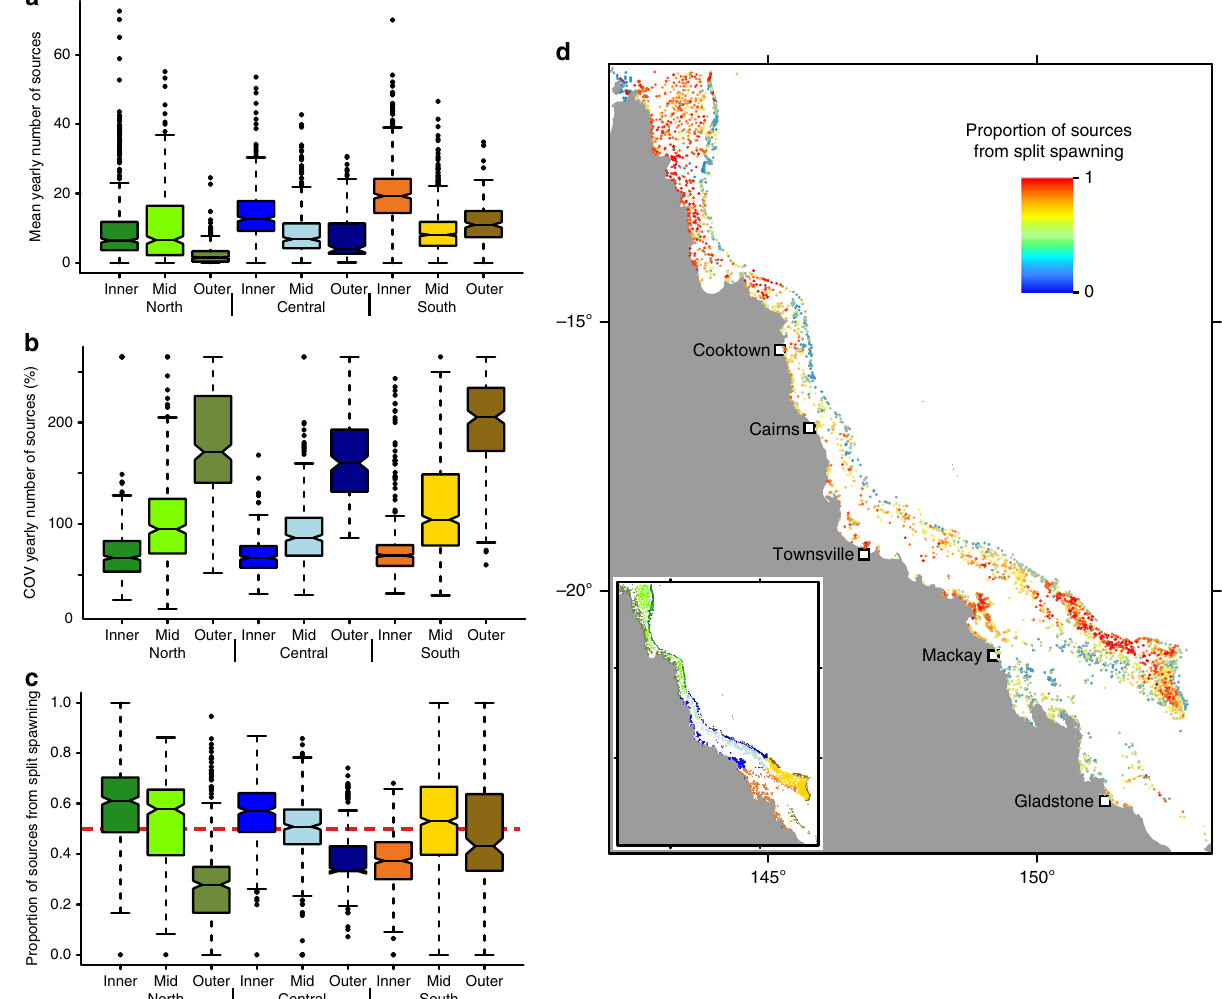
Fig. 3 Patterns of the diversity of external larval sources and the effects of split spawning. Relative number of sources of coral larvae for reefs in each GBR section with split spawning summarized as ( a ) mean number of sources per year and ( b ) temporal variation in the number of sources expressed as the coef fi cient of variation of the annual number of sources. ( c ) Mean proportion of annual sources contributed by the second spawning in split spawning scenarios. For reference, a value of 0.5 (red dashed line) implies that an equal number — but a distinct set — of sources are provided by each consecutive spawning month. ( d ) Map showing locations of reefs and the mean proportion of sources reef contributed by the second spawning in the split spawning scenarios. The colours of the boxes in ( a ), ( b ) and ( c ) correspond to the colour scheme of the GBR sectors shown in the inset in ( d ). In boxplots, the centre line represents the median, the upper and lower limits of the box represent the third and fi rst quartile respectively, the notches in the boxes represent the con fi dence interval around the median (equal to ±1.58 times interquartile range divided by square root of the sample size), the whiskers extend up to 1.5 times the interquartile range from the bounds of the box, and the points represent outliers beyond the limits of the whiskers. In ( d ) blue hues show reefs that had most of their larval sources in the fi rst spawning of the year, red hues show reefs that had most of their larval sources in the second spawning of the year, and yellow hues show reefs that had comparable number of larval sources from both spawnings in a year. COV = coef fi cient of